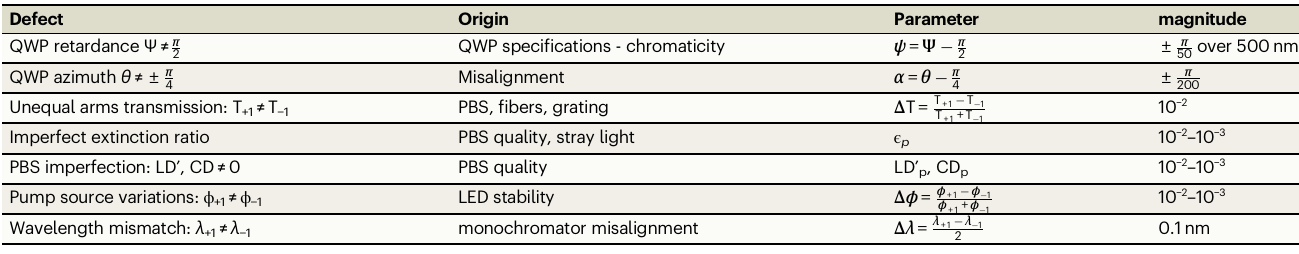
Table 1 | The different defects of the setup limiting the experimental measurements, their origin, the parameters describing them, and their magnitudes Defect